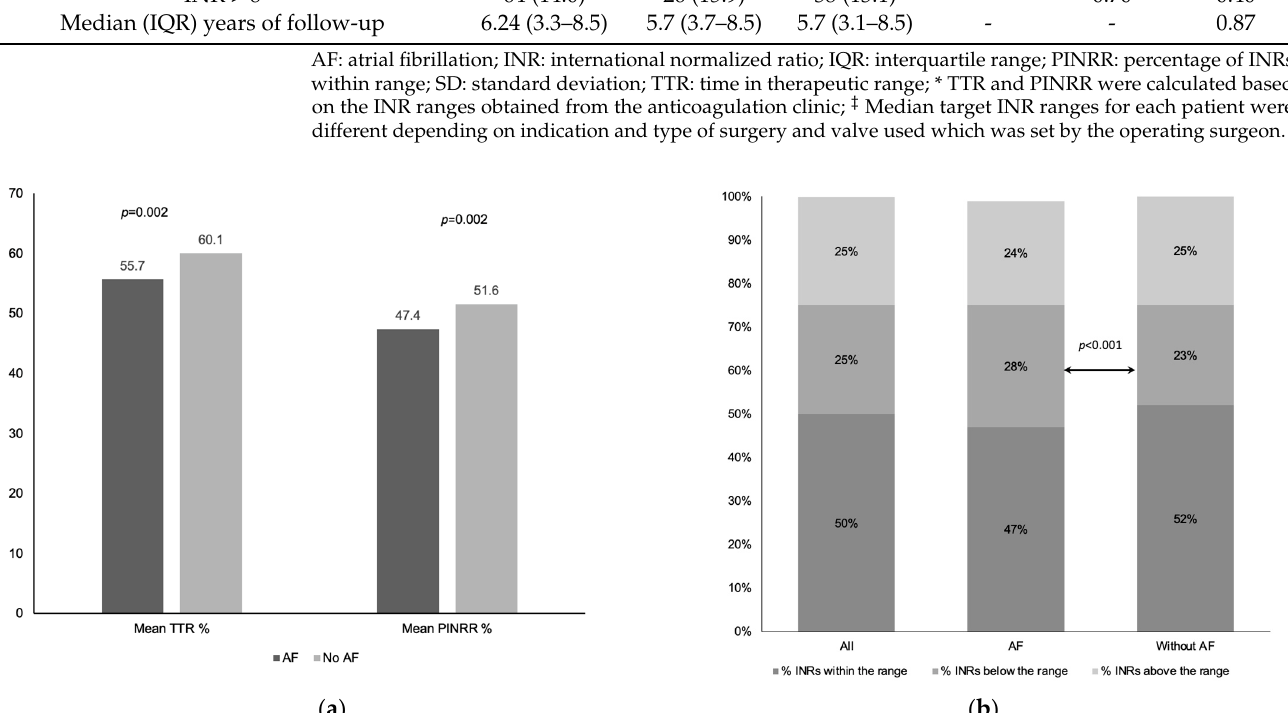
Figure 2. ( a ) Mean TTR and PINRR among operated valvular heart disease, with and without AF; ( b ) Percentage of INRs within, below and above the range among operated valvular heart disease, with and without AF.